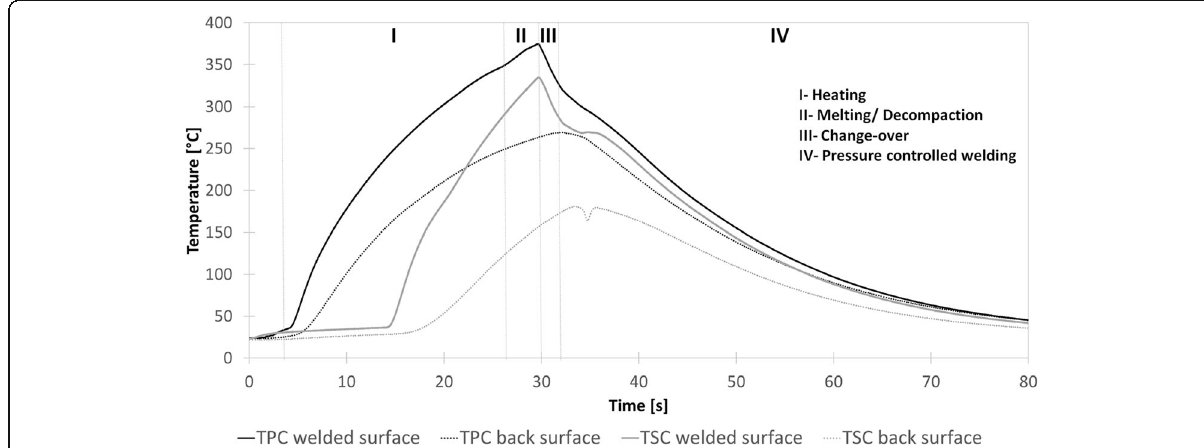
Fig. 5 Measured temperature profiles during IR